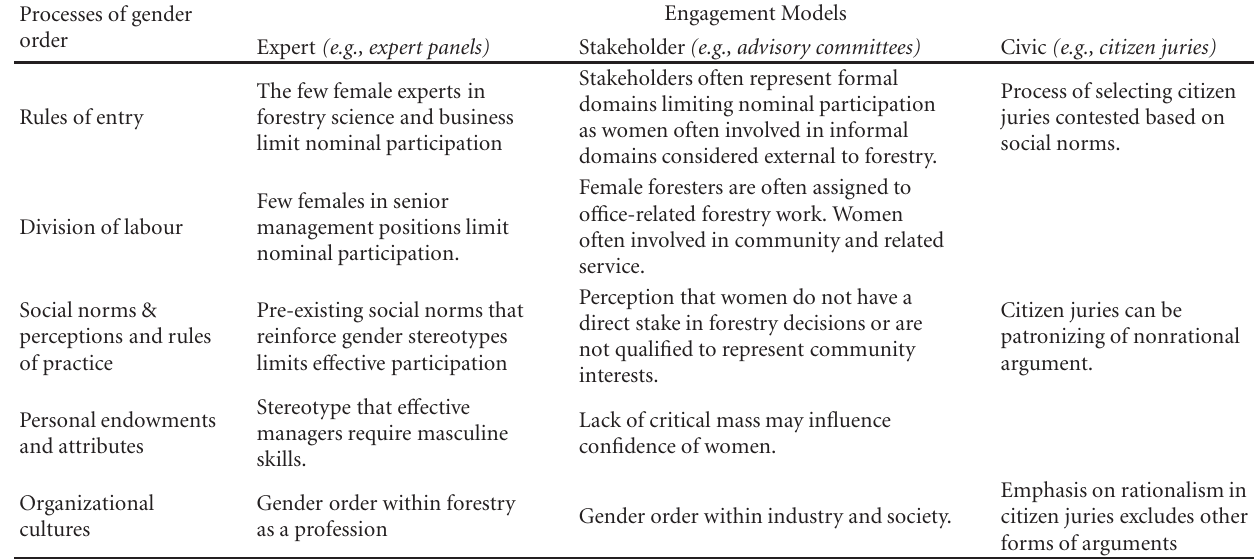
Table 2: Examples of influence of gender order on inclusivity of engagement